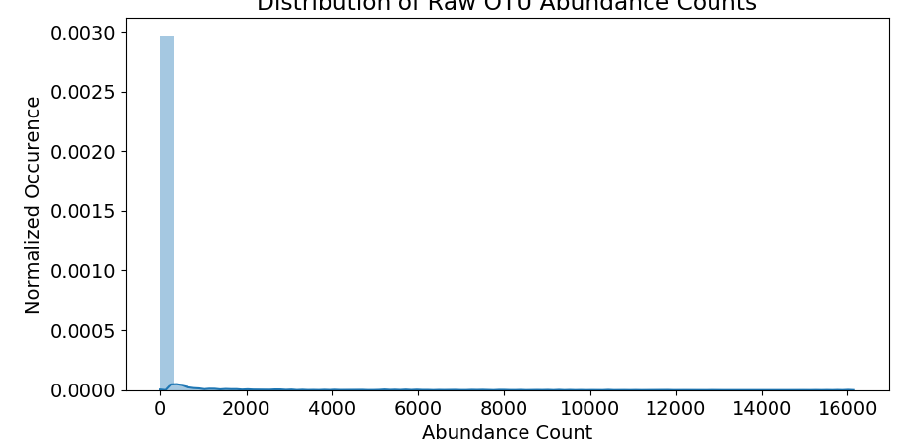
Figure 4. Distribution of all available raw operational taxonomic unit (OTU) abundance counts.